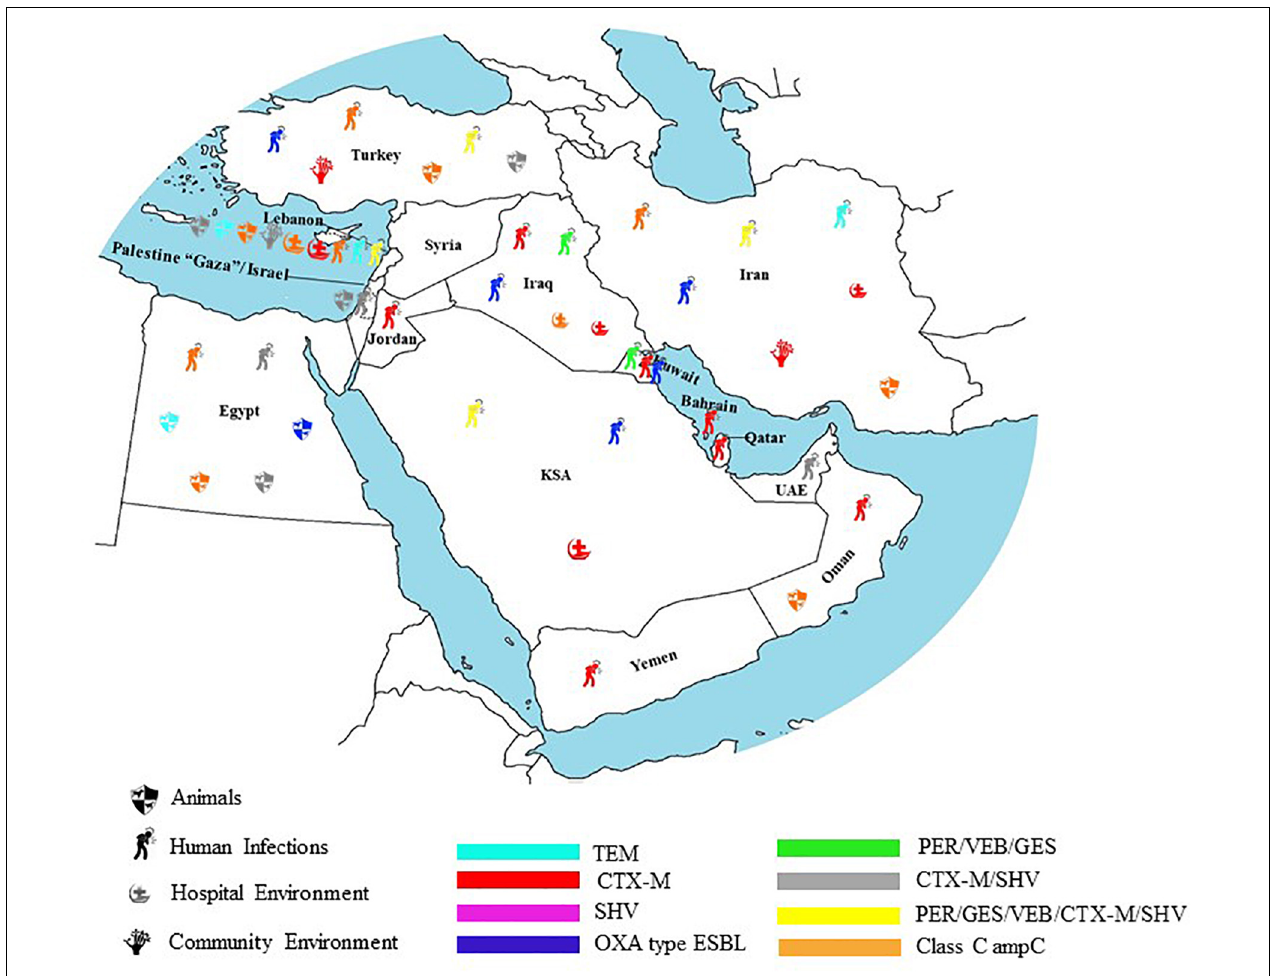
FIGURE 1 | Geographical distribution of ESBL in humans, animals, hospital, and community environment in the Middle